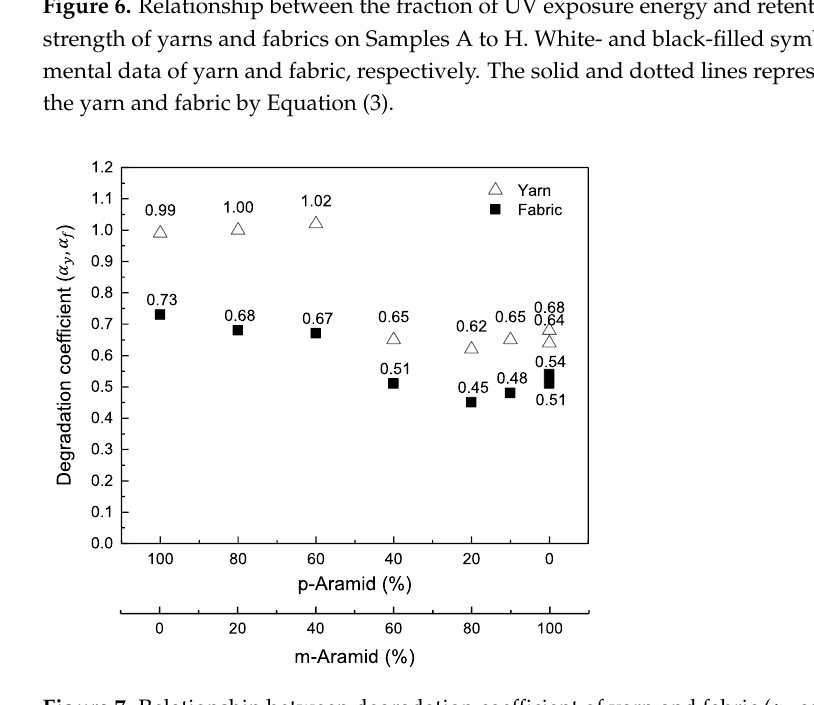
Figure 7. Relationship between degradation coefficient of yarn and fabric ( α y and α f ) by the blend of m-Aramid/p-Aramid based on Equation (3). Table 5. Difference of degradation coefficients of yarn and fabric ( α y and α f ) by the blend of m-